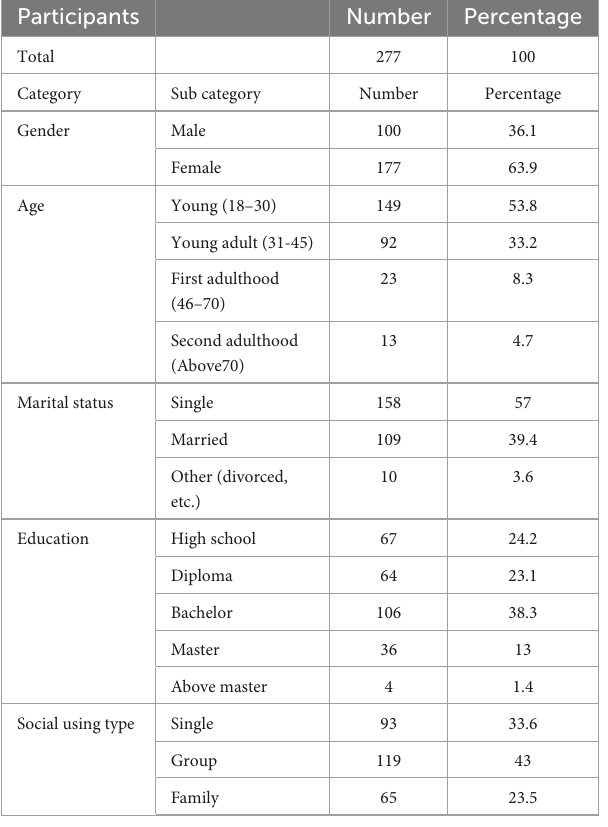
levels), visiting times (three options), and regular visits in social groups (single, group, or